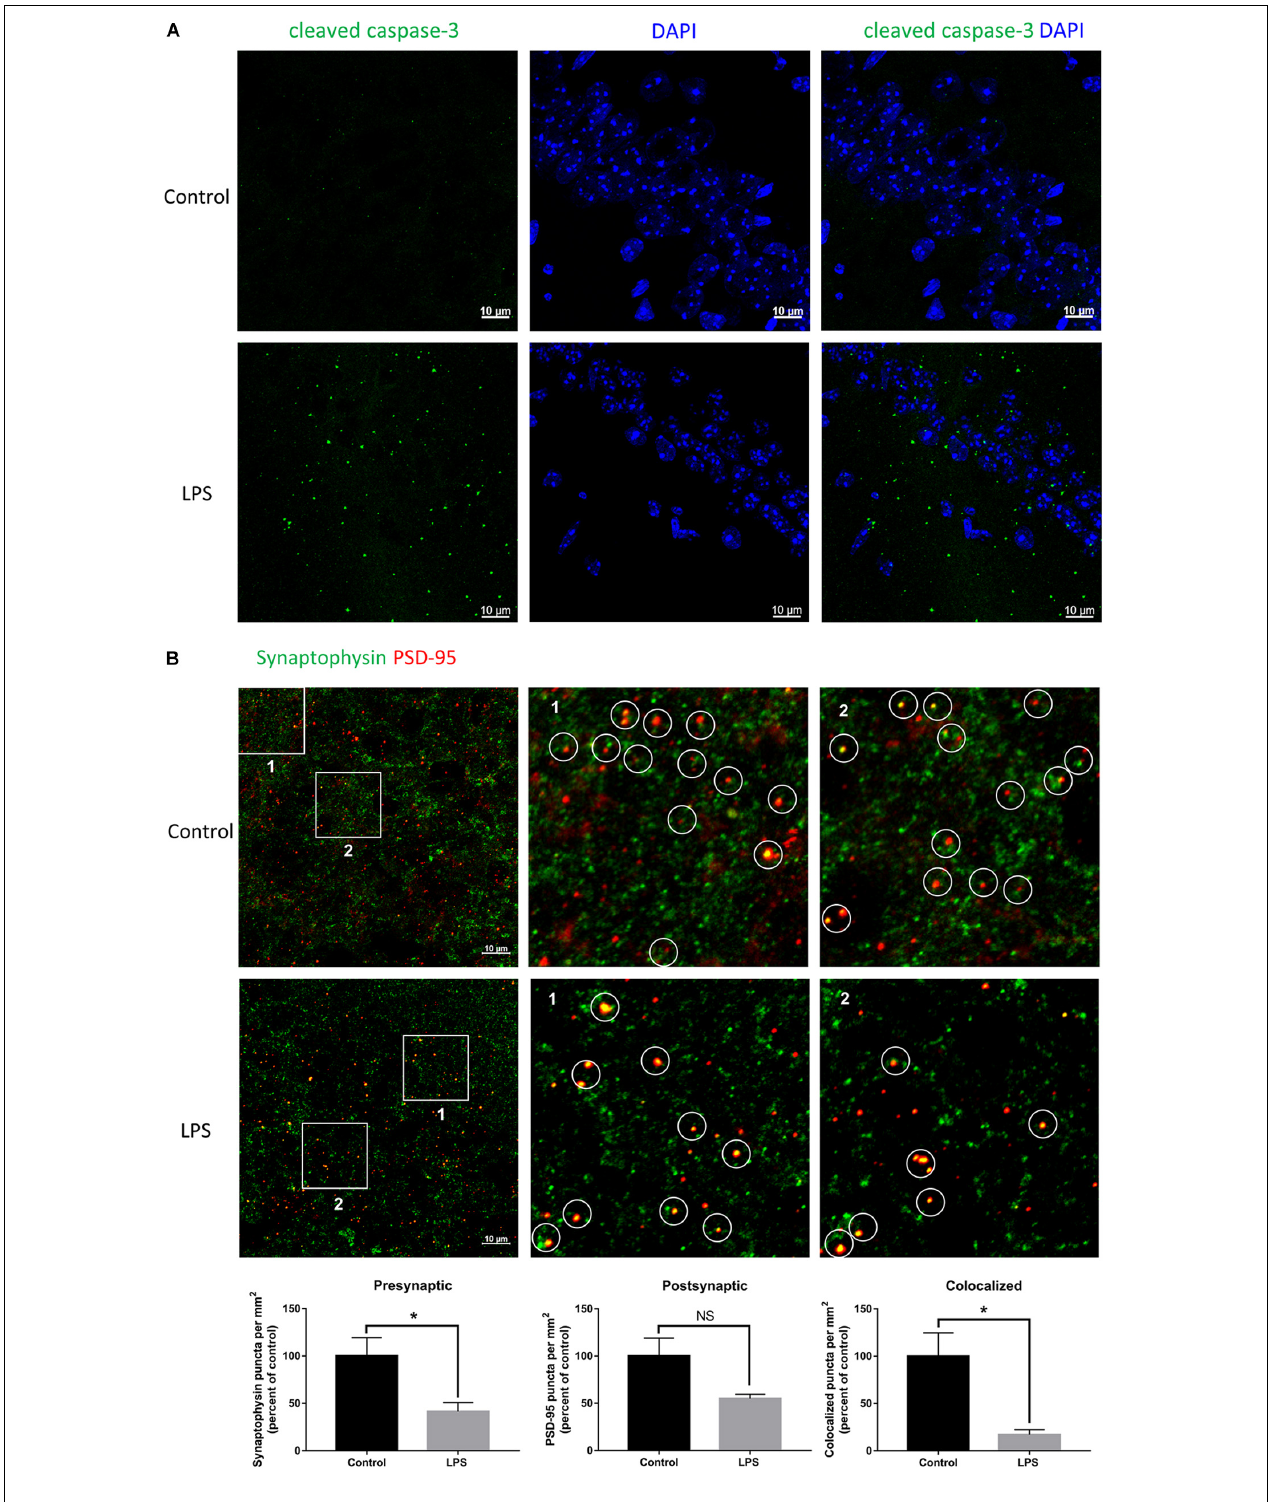
FIGURE 2 | Effects of LPS on neurons and synapses in the hippocampus. (A) Immunostaining of neurons with cleaved caspase-3 at the hippocampal CA1 region of the control and LPS-injected mice. DAPI was used to stain the nucleus. (B) Immunostaining and quantification of colocalized presynaptic and postsynaptic puncta using synaptophysin and PSD-95 as the markers, respectively, at the hippocampal CA3 region of the control and LPS-injected mice. ∗ P < 0.05, NS, no significant, by unpaired two-tailed t -test, n = 5.